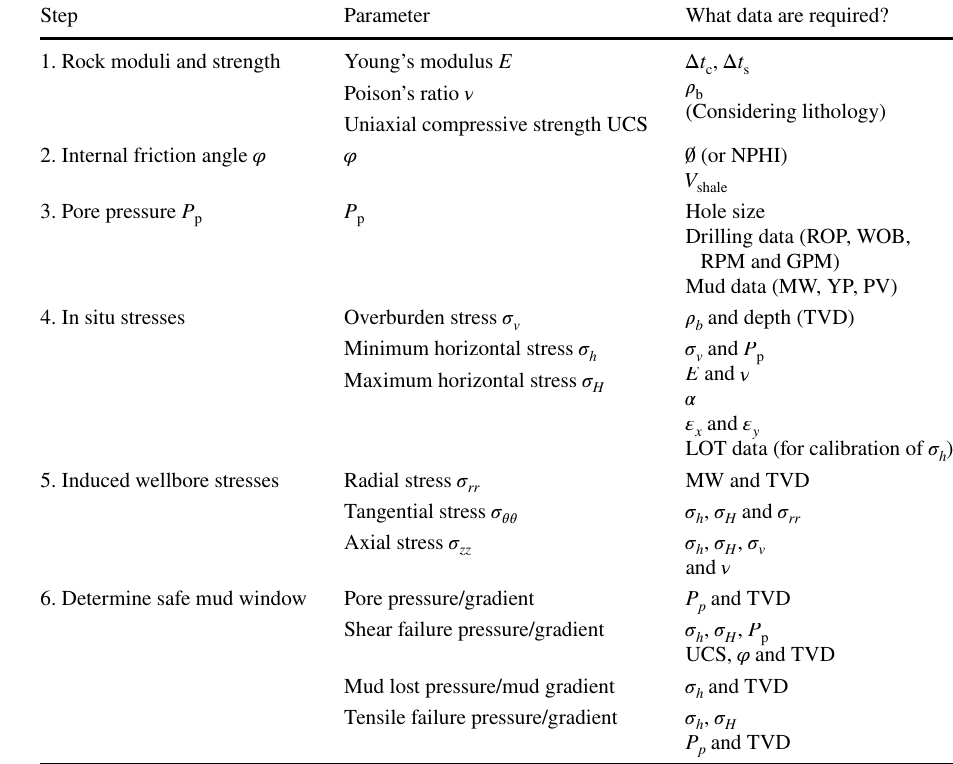
Table 8 Steps and parameters in the procedure for constructing the MEM